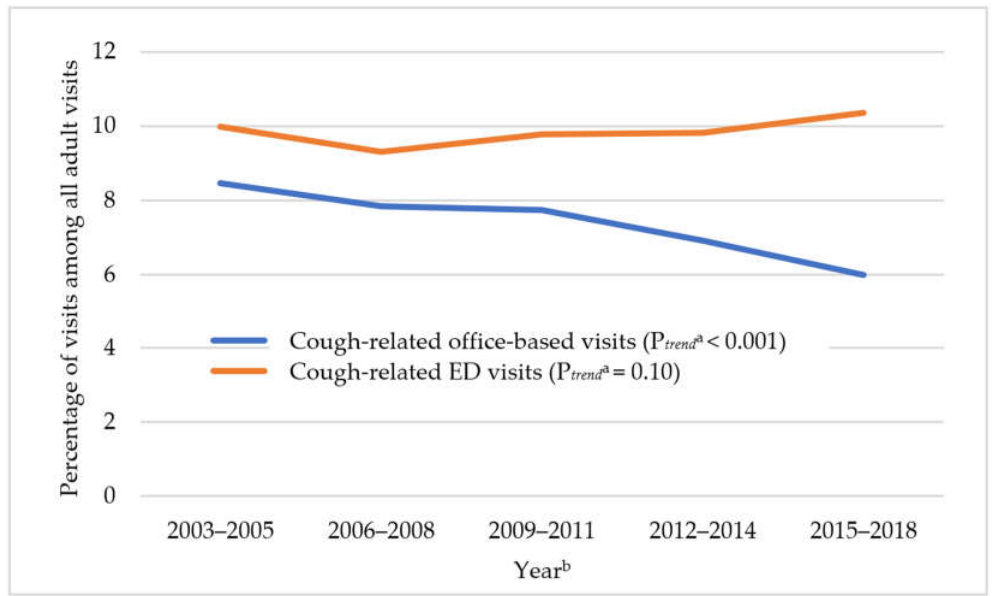
Figure 1. Trends in prevalence of adult cough-related visits among all adult visits in US